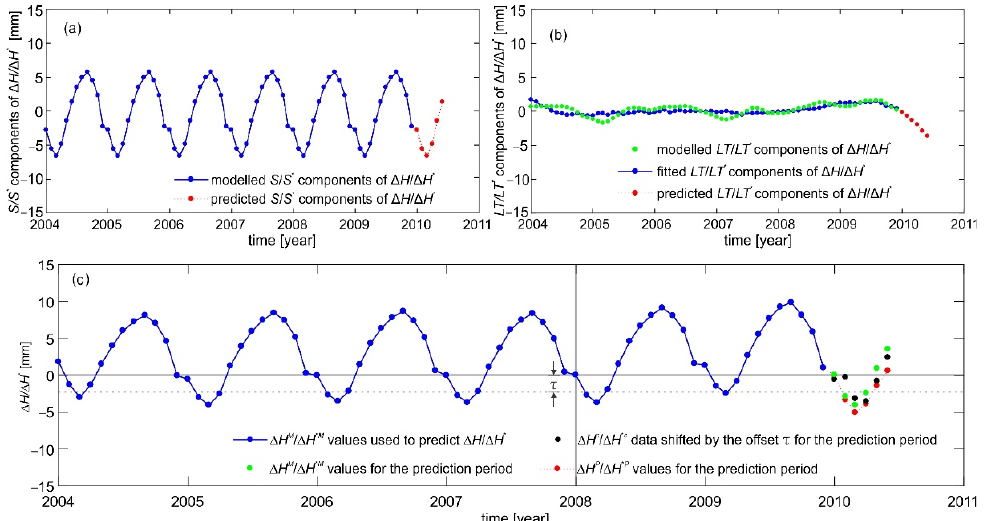
Figure 13. Example of ( a ) seasonal components ( S / S * ) of Δ H / Δ H * and their predicted values, ( b ) long ‐ term components ( LT/LT * ) of Δ H / Δ H * and their fitted values resulted from the 7th degree polynomial model, and ( c ) Δ H M / Δ H * M model used to predict Δ H / Δ H * together with Δ H c / Δ H * c data shifted by the offset τ , Δ H M / Δ H * M values and Δ H P / Δ H * P values for the prediction period. Table 1. Statistics of differences δ P 1 between Δ H P / Δ H * P and Δ H M / Δ H * M as well as differences δ P 2 between Δ H P / Δ H * P and Δ H c / Δ H * c data shifted by the offset τ (mm).